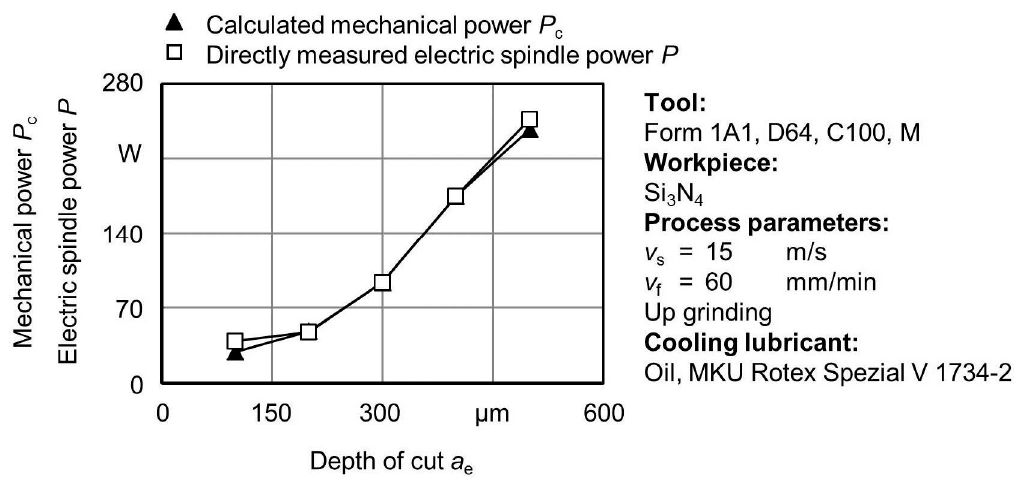
Figure 1. Comparison of calculated mechanical power P c with directly measured electric spindle power P .